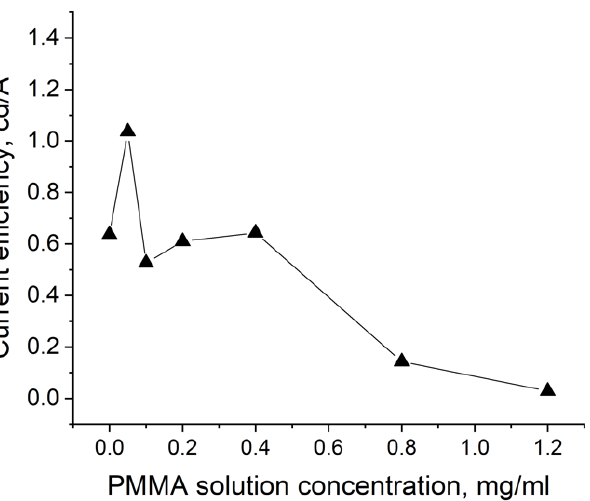
Figure 4. Effect of the PMMA solution concentration on the current efficiency of the QDLED device at 9 V.